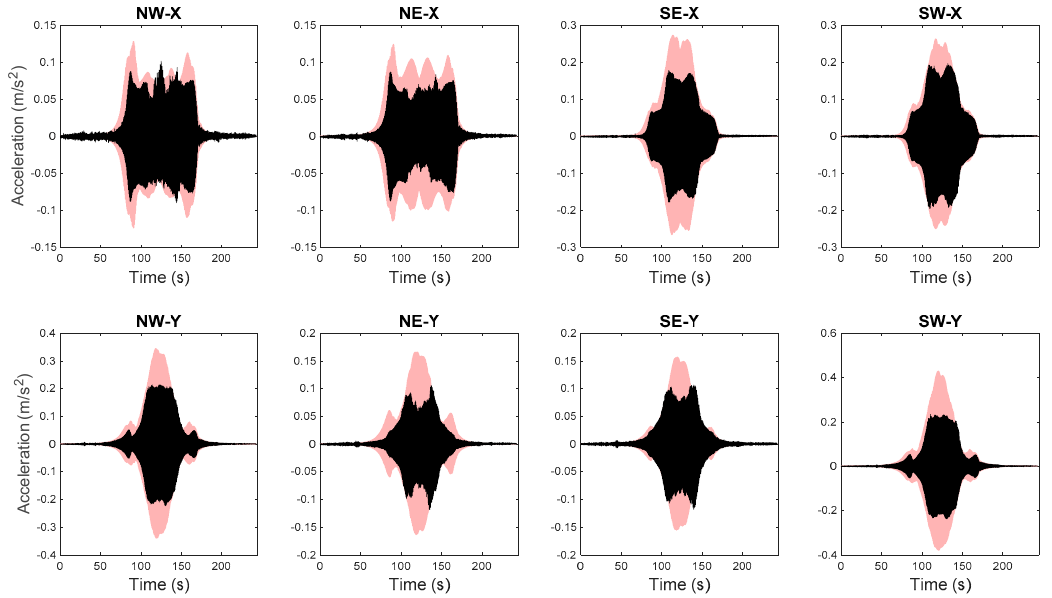
Figure 16. Acceleration time history predictions and measured counterparts (light pink areas refer to 95% quantiles and black lines denote measured data) [56].